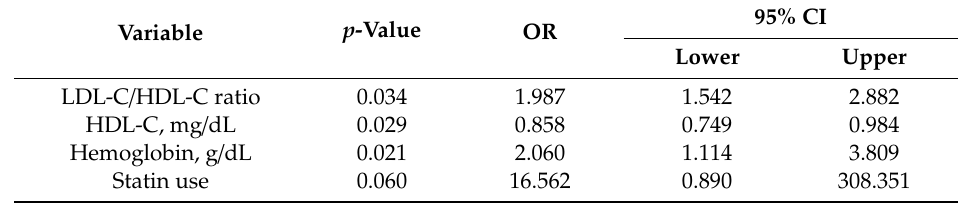
Table 4. Multiple logistic regression analysis showing independent predictors of